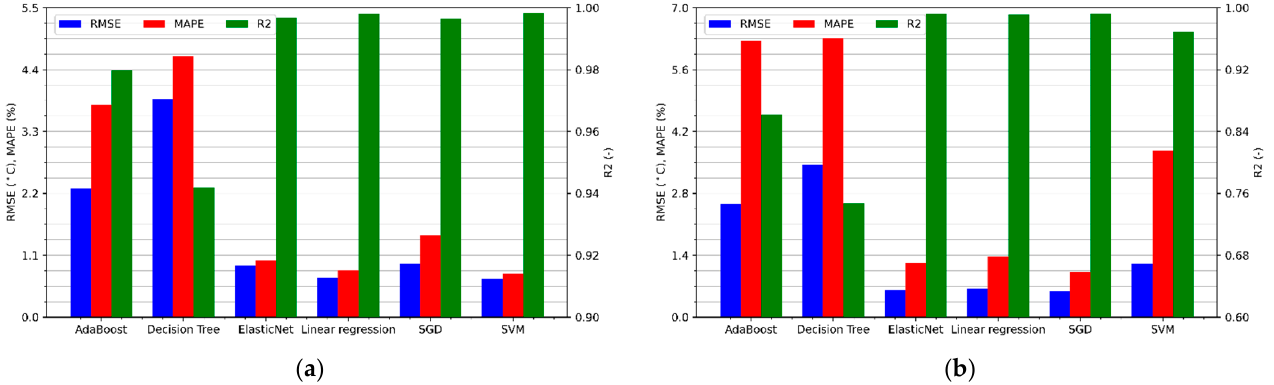
Figure 9. Regression metrics values for the temperature estimation supported with casing sensor data of the motor: ( a ) without cooling; ( b ) with a cooling fan.